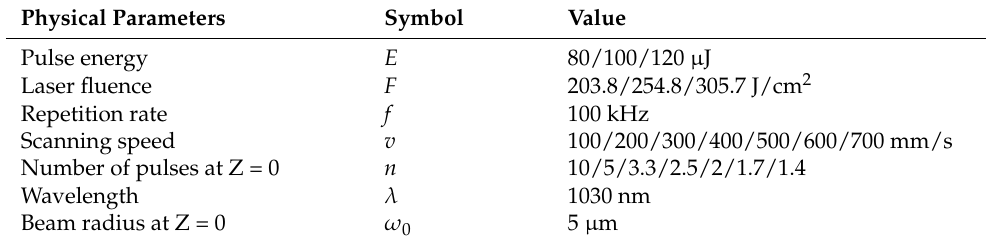
Table 2. Basic processing parameters of femtosecond laser ablation for TTM